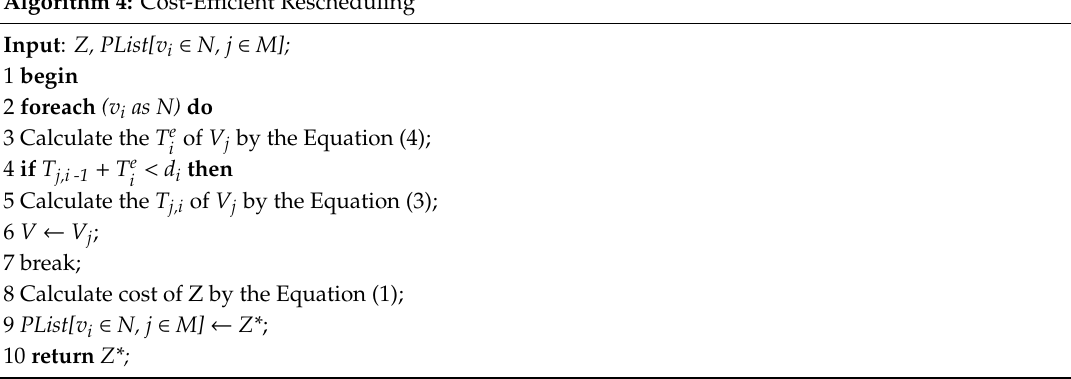
Algorithm 4: Cost-E ffi cient